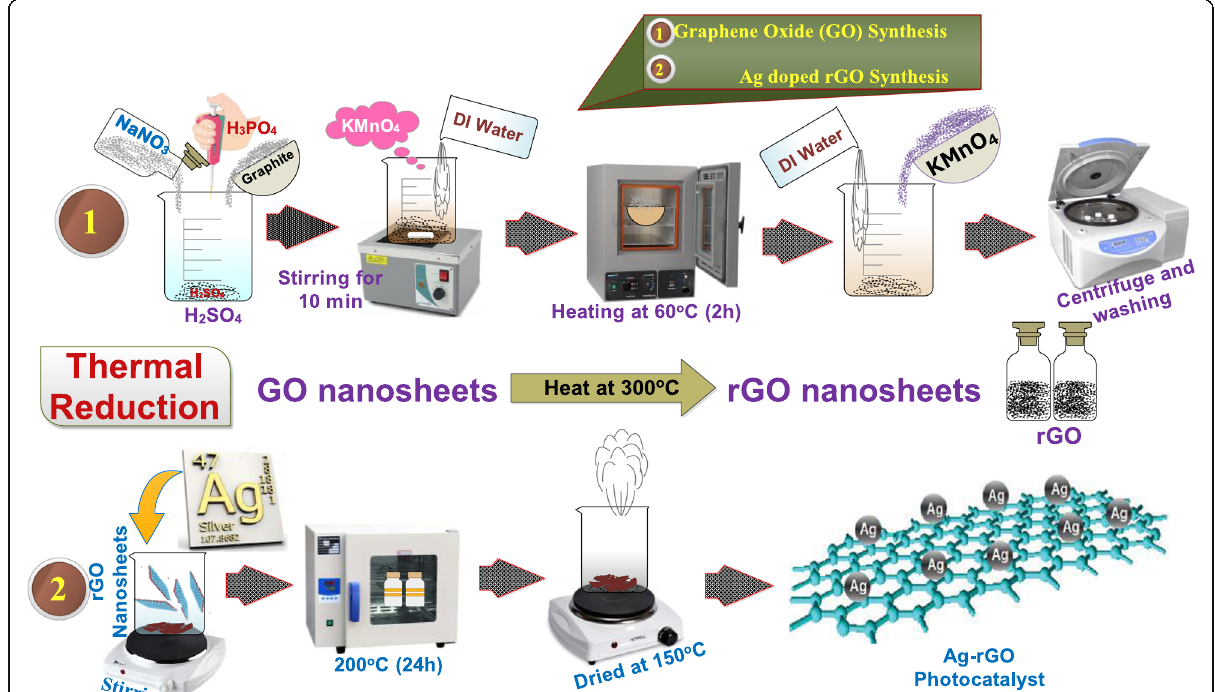
Fig. 1 Synthesis process for GO and Ag-doped